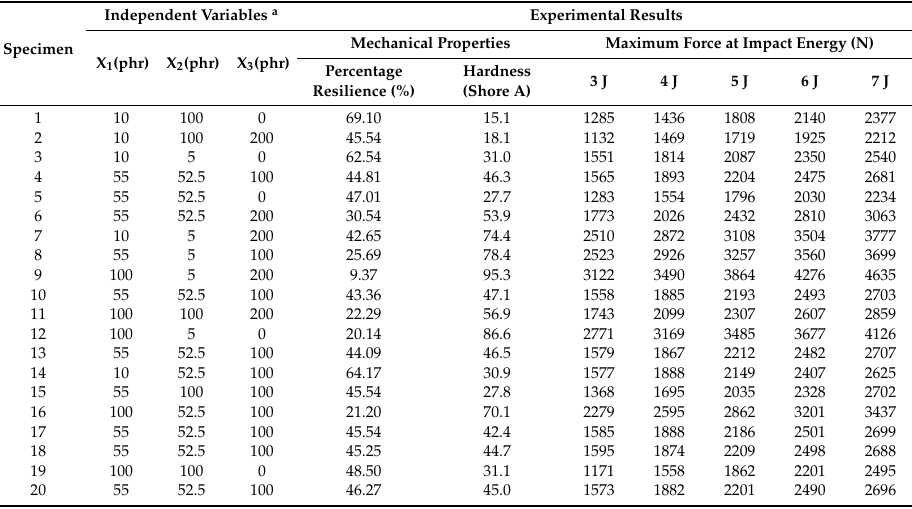
Table 2. Test results based on the design of experiment (DoE) matrix employed in this